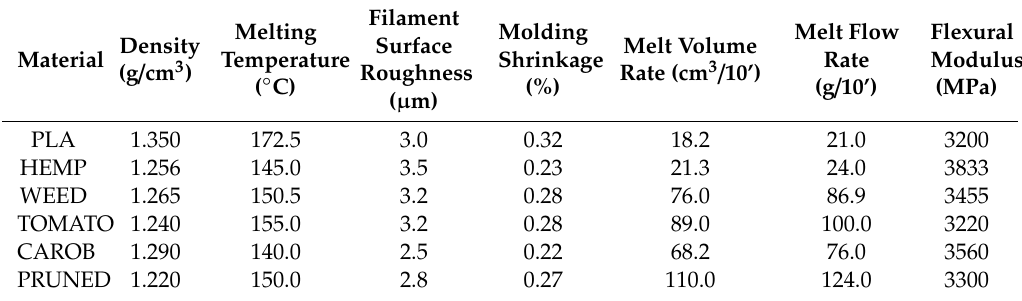
Table 3. Main manufacturing capability of new bio-plastic compounds in comparison with pristine polylactic acid (PLA) filament.